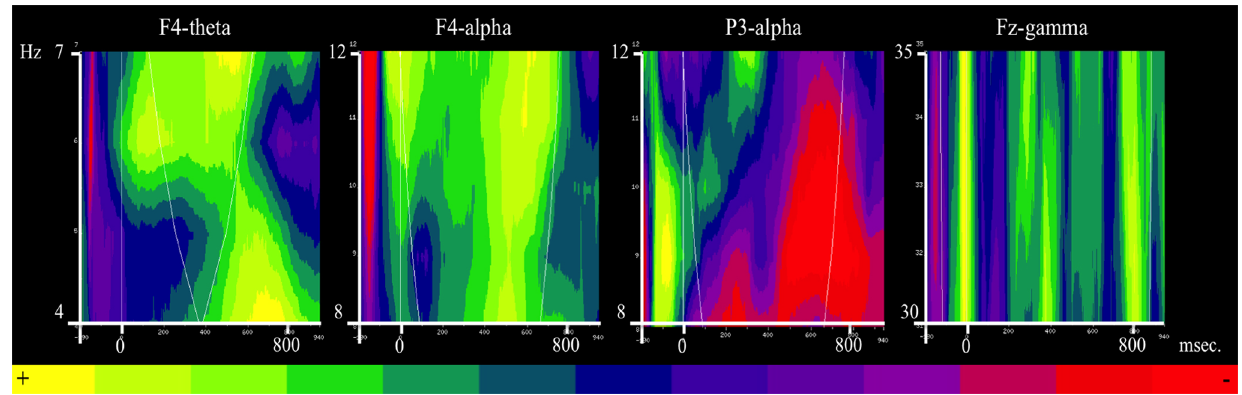
Figure 3. Time frequencies analysis. From the left: Z value for the contrast Ironic / Literal in the theta band at F4; Z value for the contrast Ironic / Literal in the alpha band at F4; Z value for the contrast Ironic / Literal in the alpha band at P3 and Z value for the contrast Ironic / Literal in the gamma band at Fz.